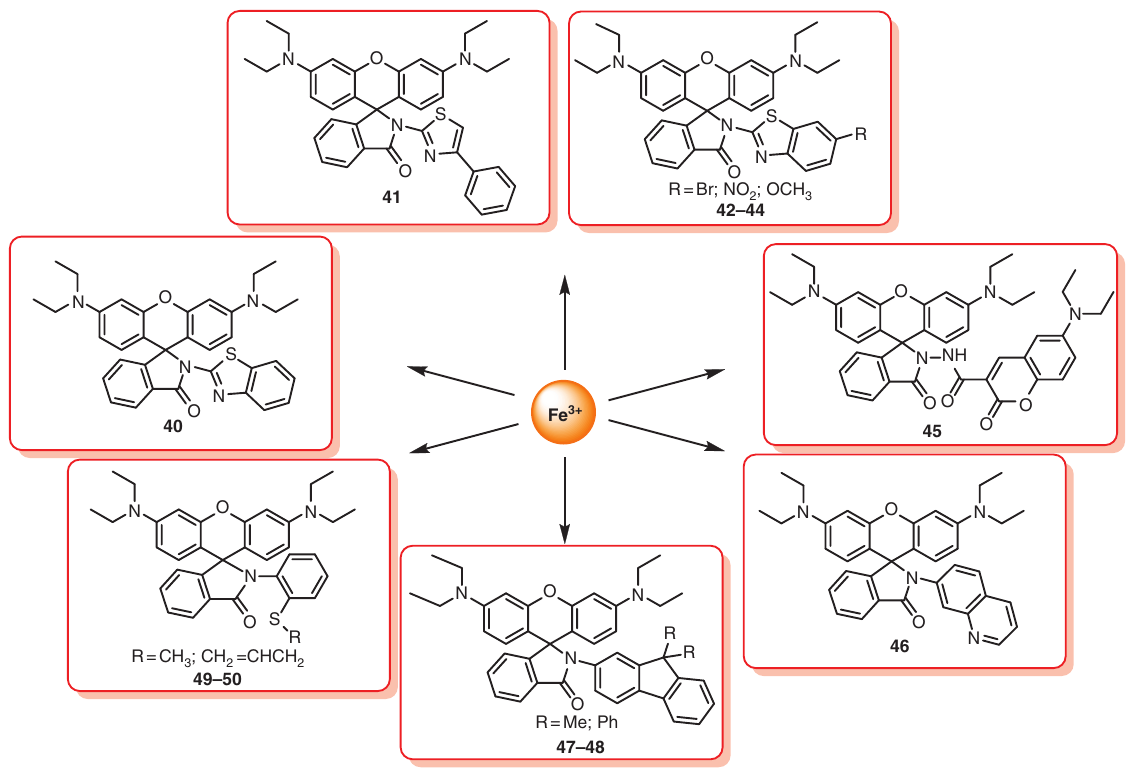
Figure 27: Probes 39–48 based on rhodamine with amine for detecting Fe 3 +